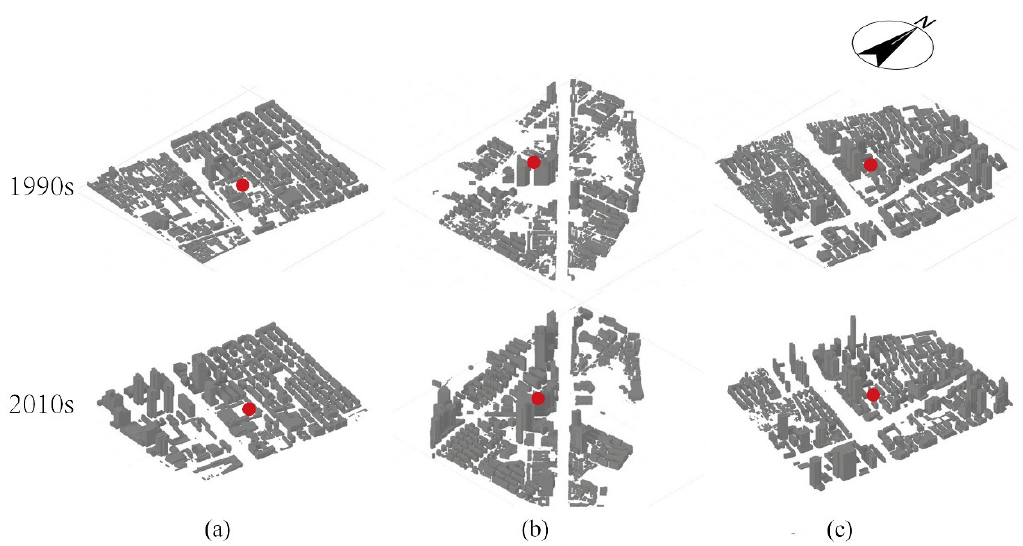
Figure 2. Bird’s-eye view of three schools and surrounding areas in the 1990s and 2010s.